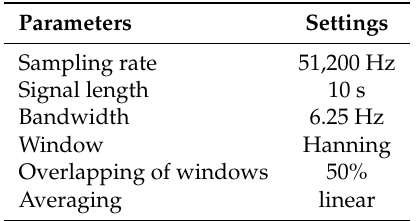
Table 1. Acoustic spectral analysis